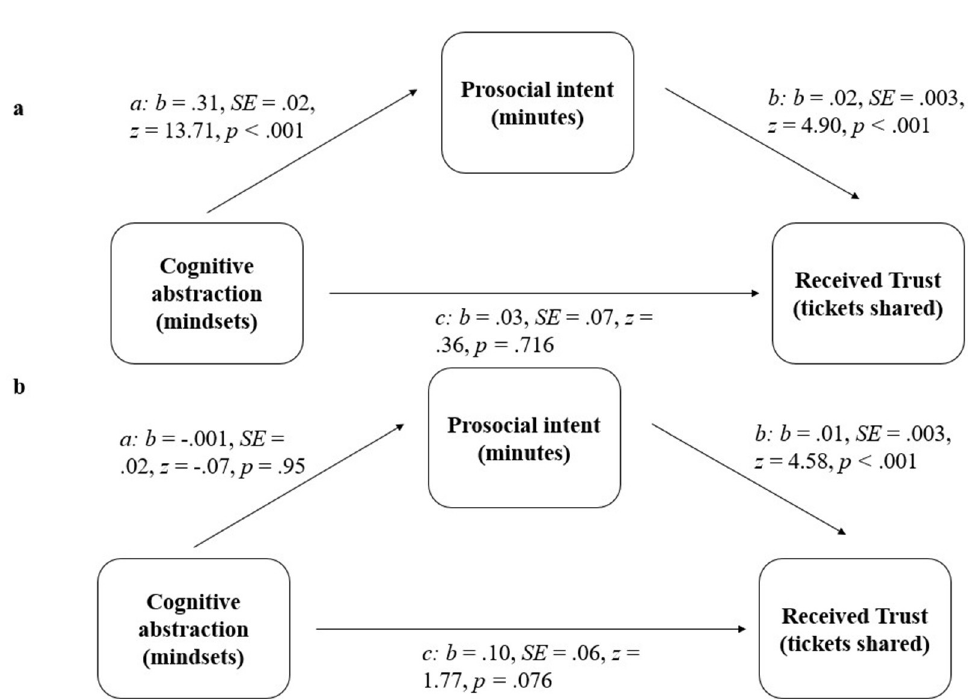
Fig 5. Path models in the public (a, above) and the private (b, below) conditions in Study 3.